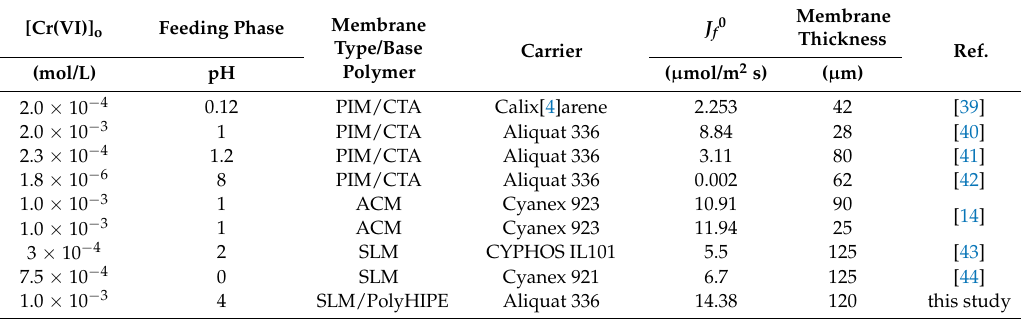
Table 3. Comparison of the Cr(VI) transport efficiency with different